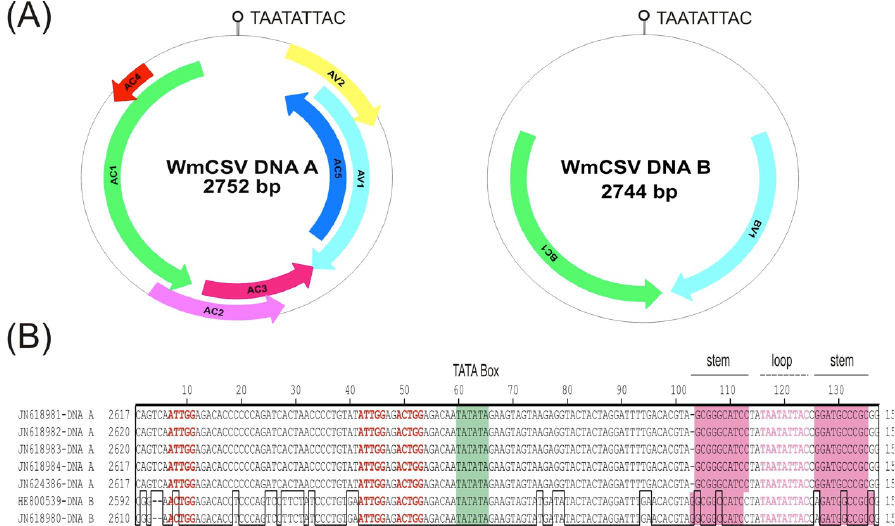
Figure 1. Arrangement of the genomic components of WmCSV ( A ). The positions and orientations of genes are shown with colored arrows. The position of the predicted stem- loop structure (containing the nonanucleotide sequence; TAATATTAC) is indicated. An alignment of the common region sequences of the DNA A and DNA B components of WmCSV isolates from Oman is shown in ( B ). Spaces (-) are introduced to optimize the alignment. Differences in sequences are indicated with boxes. Stem and loop sequences (pink highlighting and pink text, respectively) of the predicted stem-loop structure, position of iterons (red text) and TATA box (highlighted in green) of the Rep promoter are indicated.